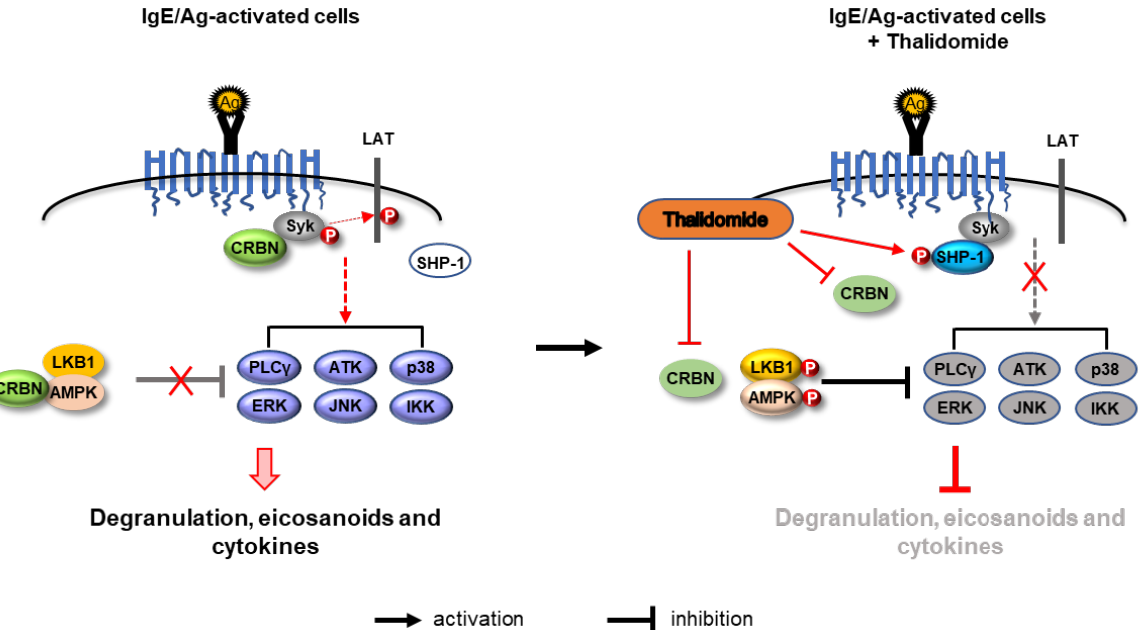
Figure 7. A possible mechanism by which thalidomide inhibits Fc ɛ RI-mediated mast cell activation. For details, please see text.